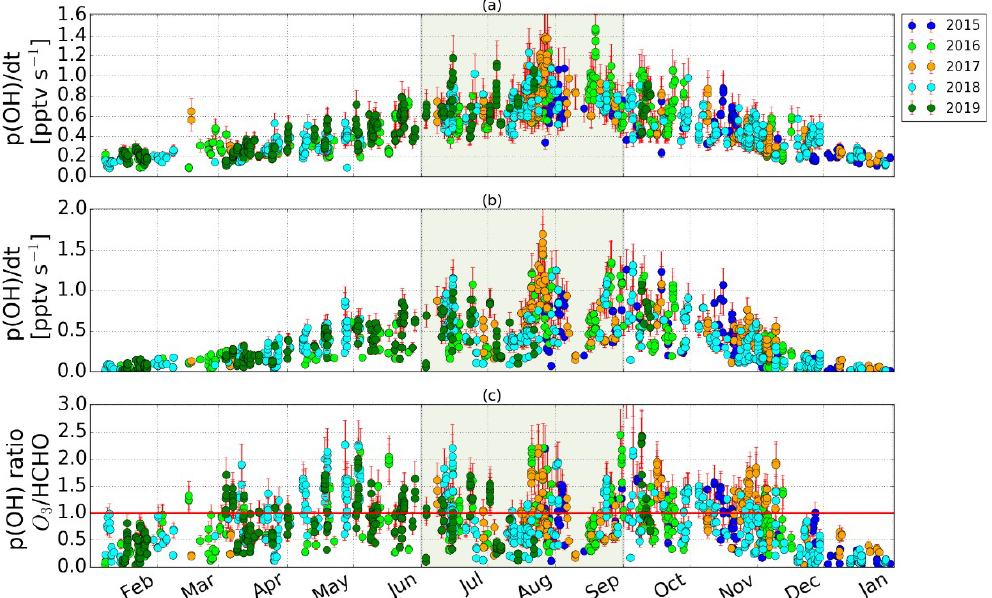
Figure 6. Total OH radical production rates from the photolysis of HCHO (a) and O 3 (b) from 2015 to 2019 over Hefei, eastern China. (c) The ratios of OH radical production rates from O 3 photolysis to that from HCHO photolysis. The grey vertical shaded area indicates summertime measurements. The red line denotes the one-to-one